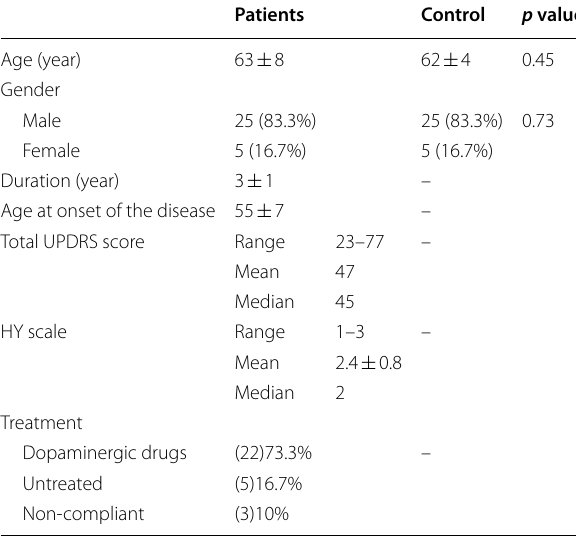
UPDRS Unified Parkinson’s Disease Rating Scale, HY Hoehn and Yahr